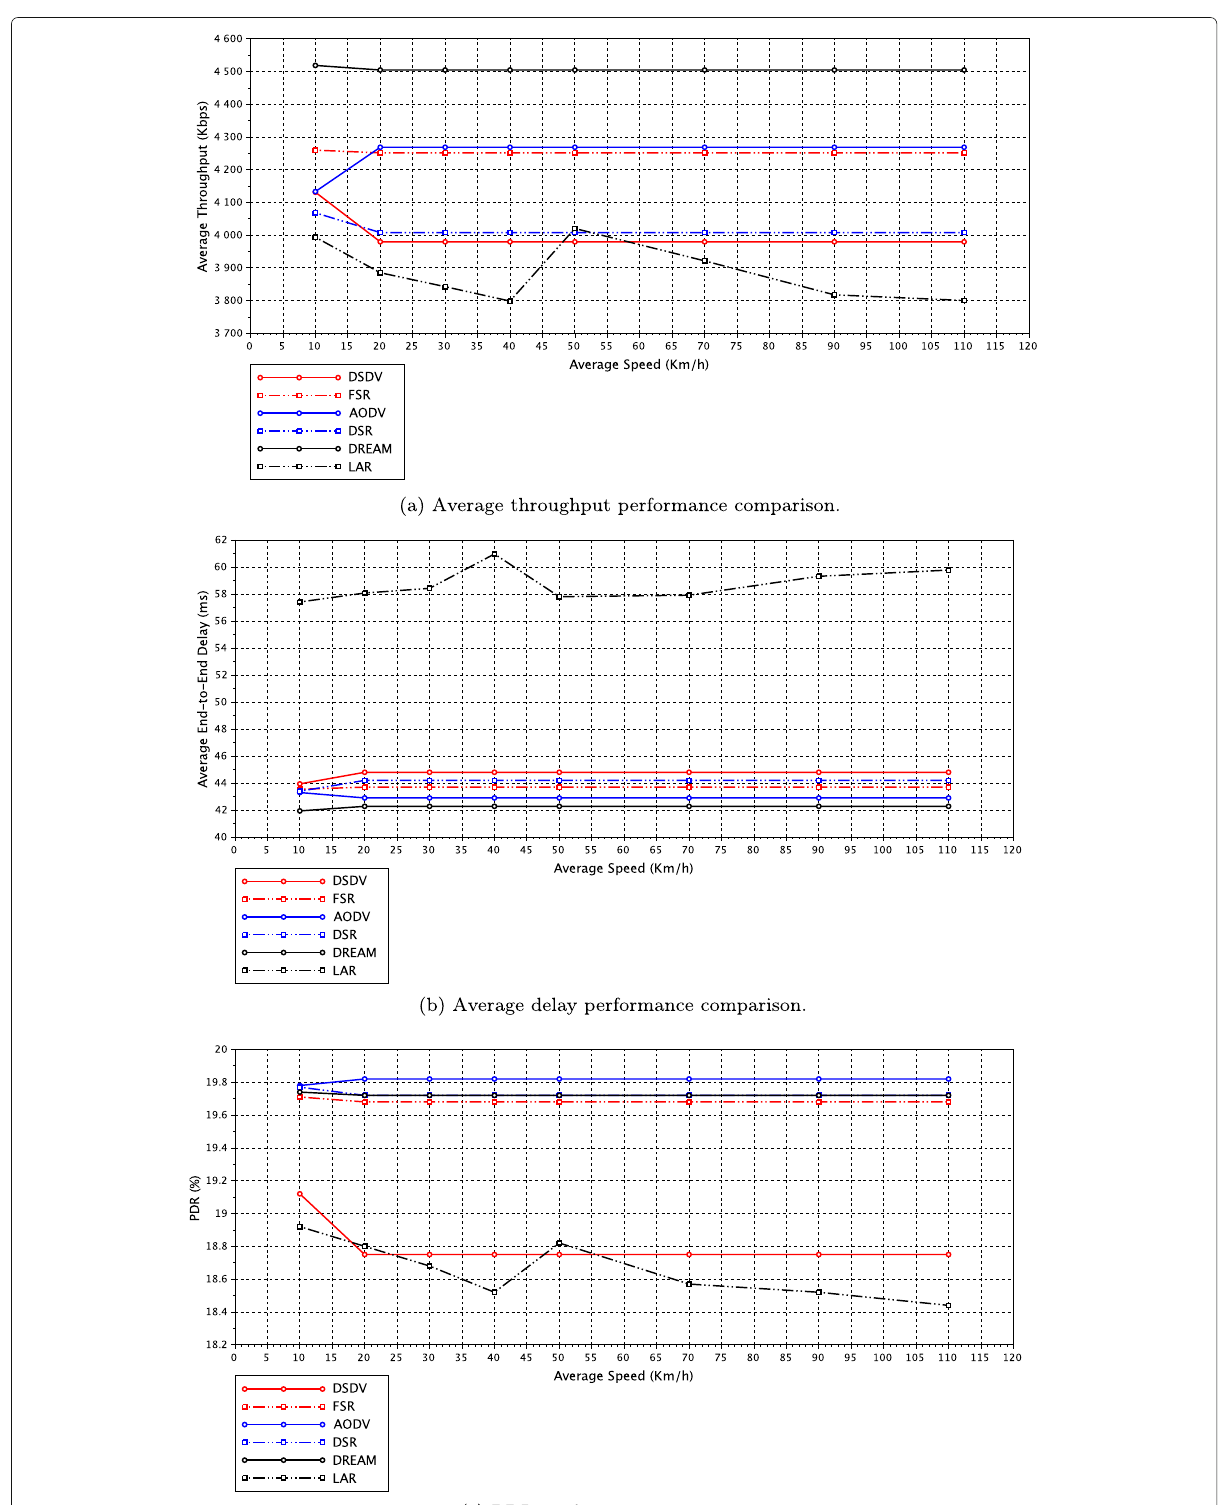
Fig. 7 Average throughput, end-to-end delay and PDR performance under varying average speed. a Average throughput performance comparison. b Average delay performance comparison. c PDR performance